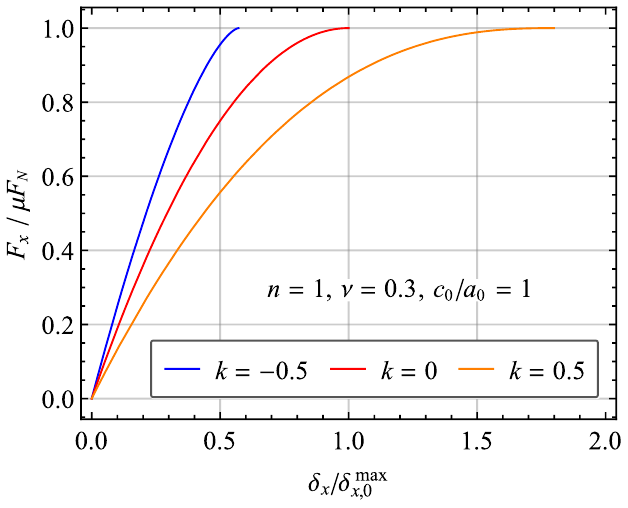
Figure 4. Influence of the exponent of the elastic inhomogeneity on the normalized tangential force as a function of the normalized tangential displacement in the case of a conical initial gap function.